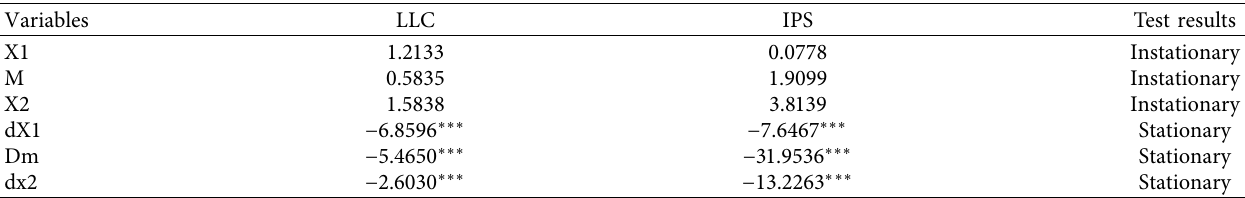
Table 9: Stationarity test of the variables.